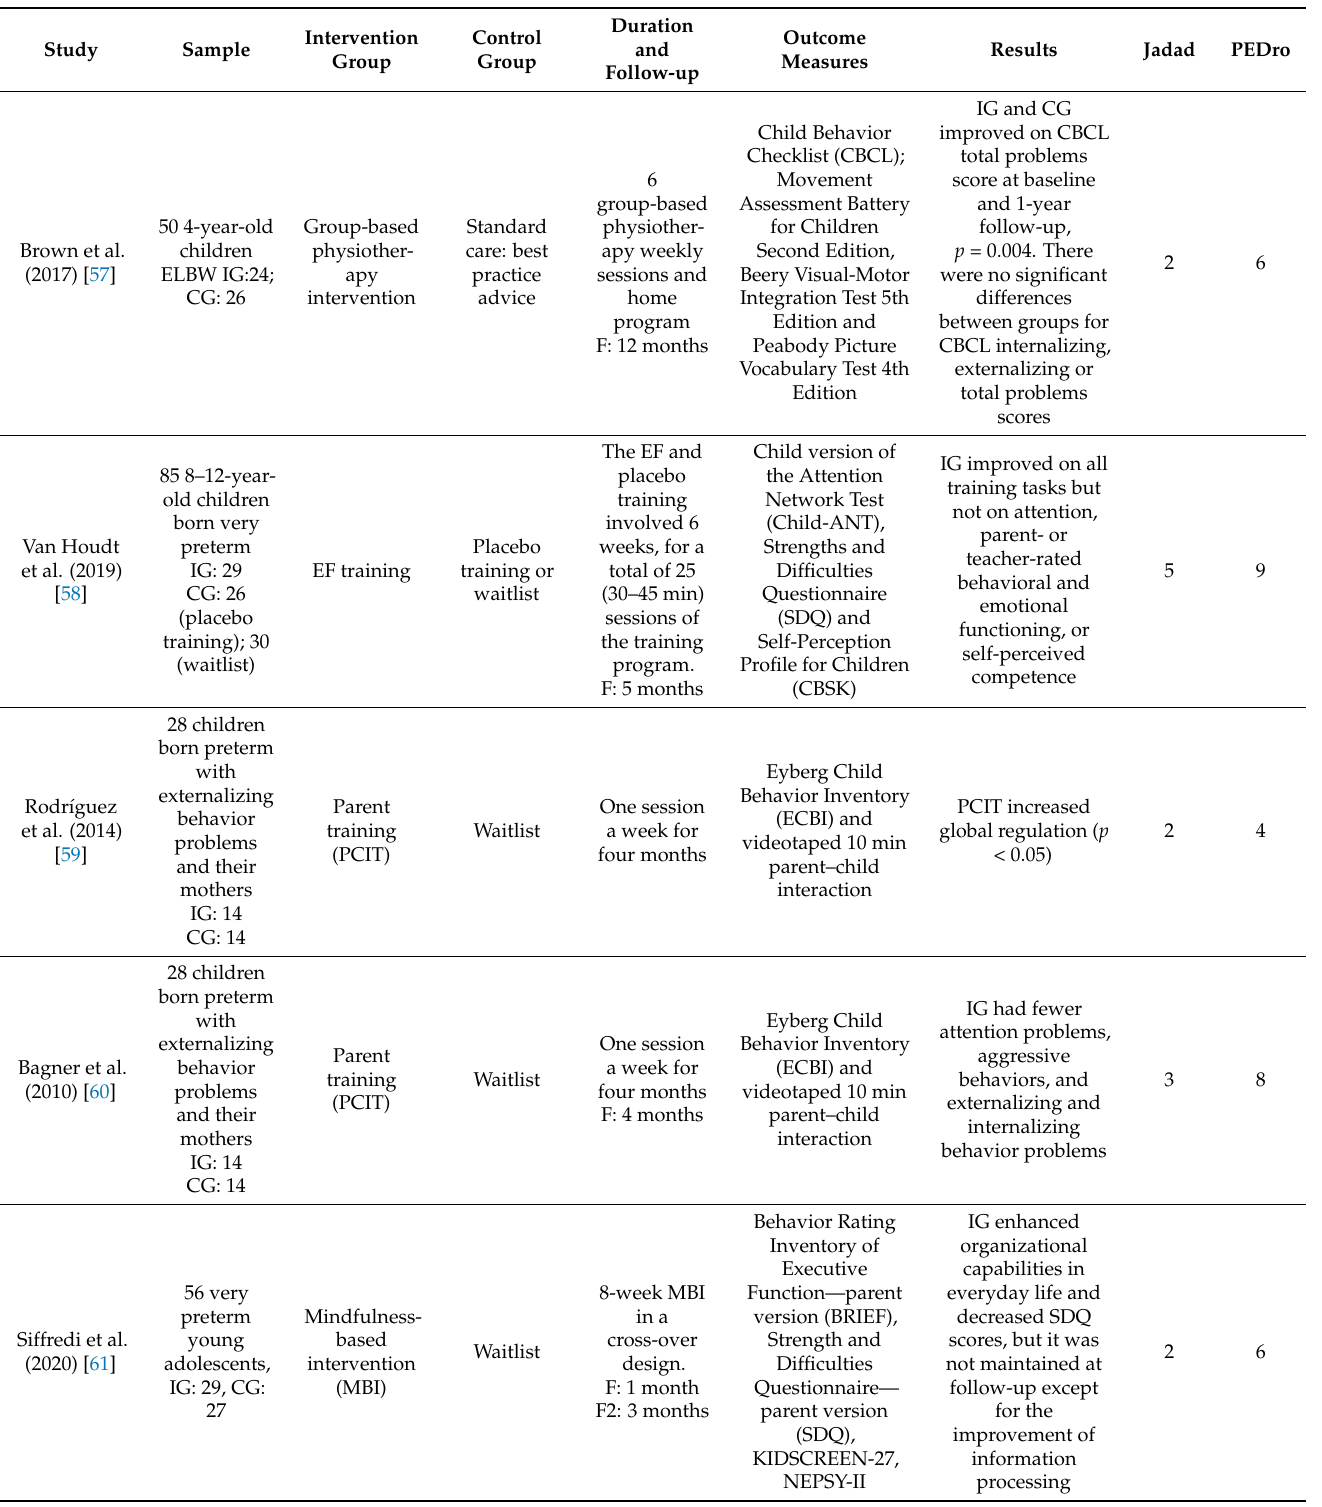
Table 1. Data Extraction of Selected